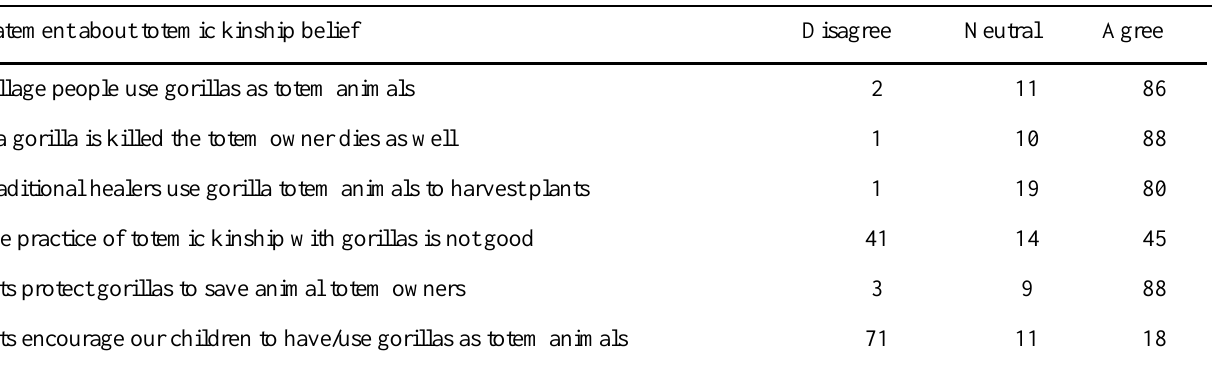
Table 1. Perception of totemic kinship practices with gorillas among interviewees in five villages of Lebialem Division, July